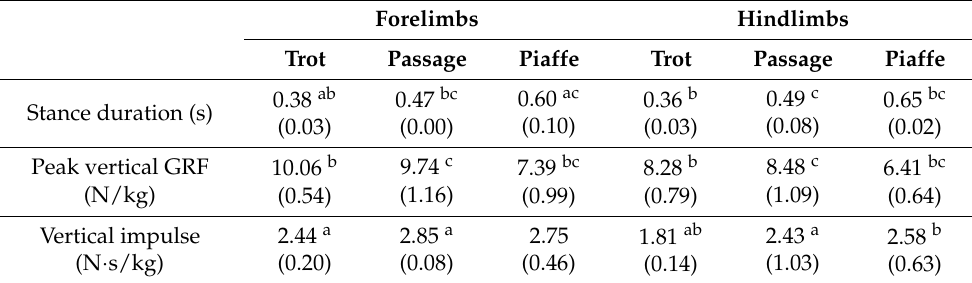
Table 3. The comparison of stance duration, peak vertical force and vertical impulse in collected trot, passage and piaffe. Data for collected trot and passage are from [8]. MANOVA was used to test the difference between gaits with post hoc Bonferroni adjusted pairwise comparisons. Significant main effects ( p = 0.001) were found between gaits. Post hoc significance ( p < 0.05) is denoted by a: trot different from passage; b: trot different from piaffe; c: passage different from piaffe. Forelimbs Hindlimbs Trot Passage Piaffe Stance duration